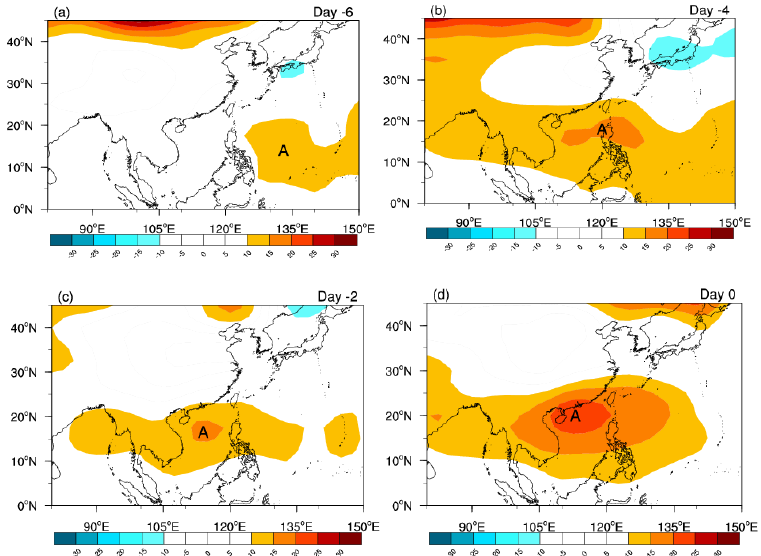
Figure 11. Composite chart of GHT 500 anomalies (shading) before the regional MHWs onset. Day 0 represents the first day of MHW, and Day-2 represents two days prior to Day 0, Day-4 represents four days prior to Day 0, and so on ( a – d